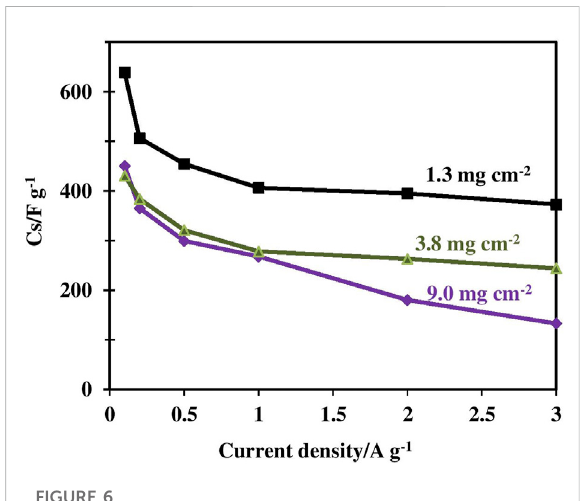
FIGURE 6 Speci fi c capacitance obtained from the galvanostatic discharge pro fi le at current densities ranging from 0.1 A g − 1 – 3.0 A g − 1 with electrodes of 0.25hM_100 TiO 2 having different mass